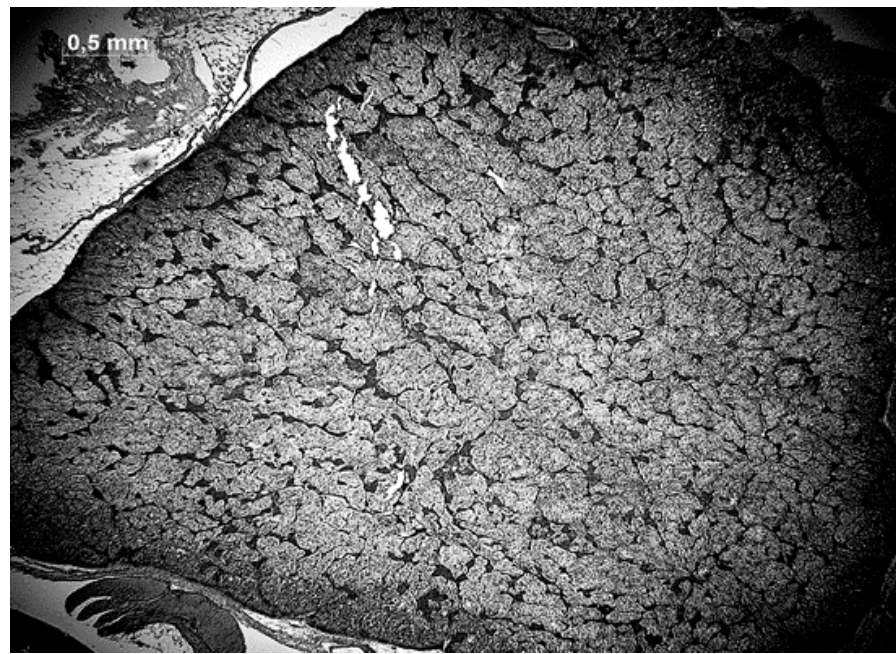
Figure 1. Adrenal gland with adrenal cells (dark grey areas) and interrenal cells (light grey areas).